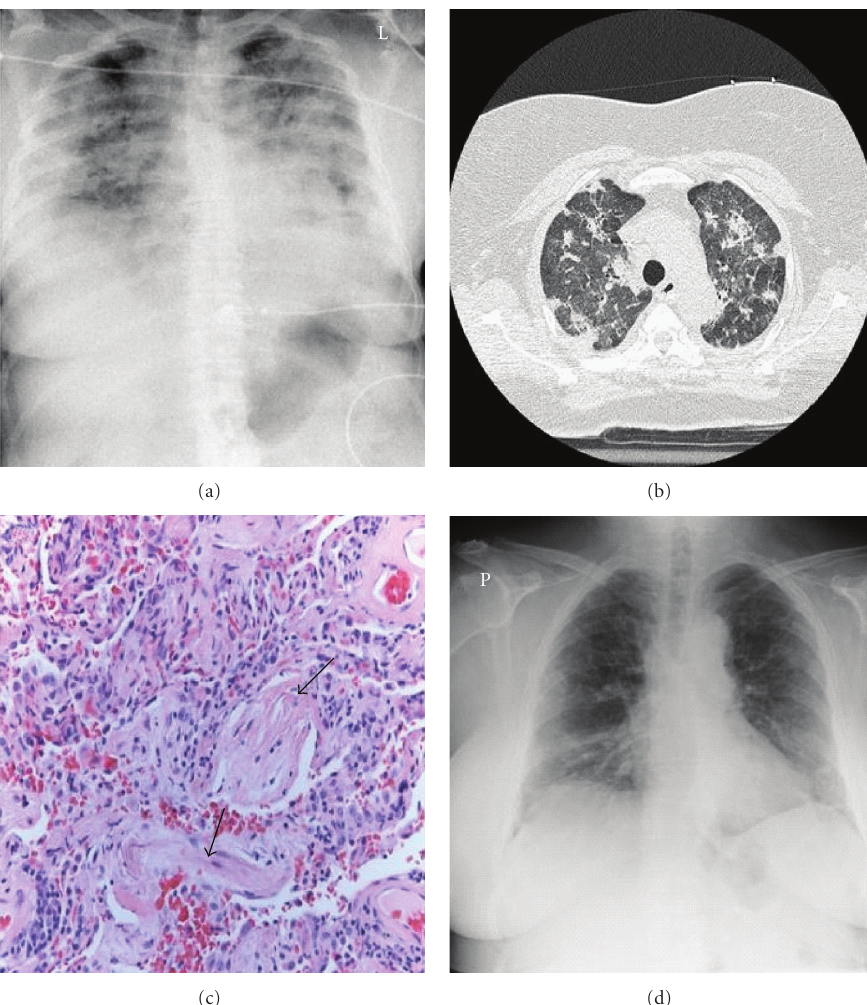
Figure 1: Radiological and histological findings of an AIP patient who was actively treated by mechanical ventilation and high doses of corticosteroids and immunosuppressive drugs. (a) Chest X-ray showing alveolar infiltrates at the time when the patient was mechanically ventilated. (b) HRCT findings of the upper lung lobes showing ground glass opacity and infiltrates. HRCT was taken on the following day after the chest X-ray shown in panel (a) Both Chest-X-ray and HRCT have been taken 2-3 days before taking the lung biopsy by VATS. (c) Lung biopsy findings of the same patient showing interstitial fibrosis and fibroblast proliferation representing late stages of organizing phase of DAD after treatment of several weeks. The patient recovered well with minimal radiological (d) and functional abnormalities within the lungs documented 4 years after the